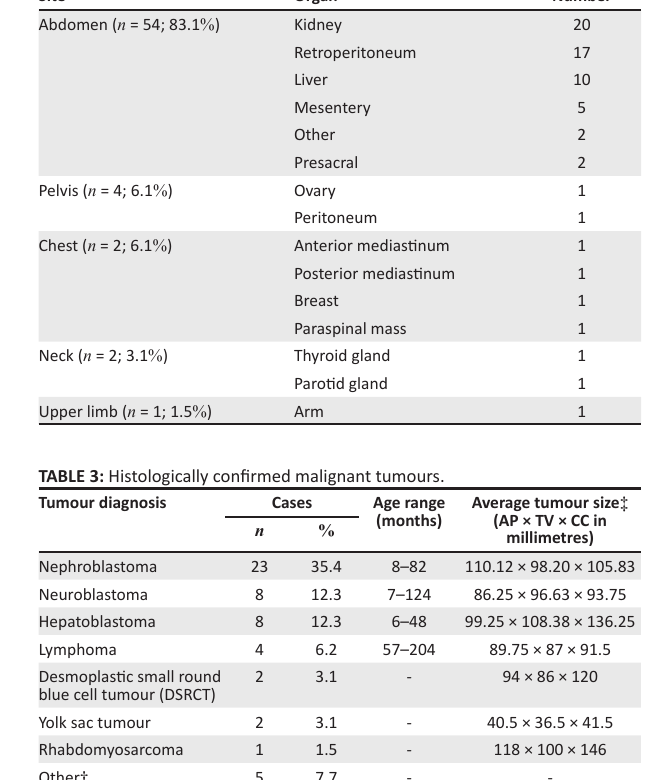
TABLE 1: Summarised results and diagnostic categories. Cytological diagnosis